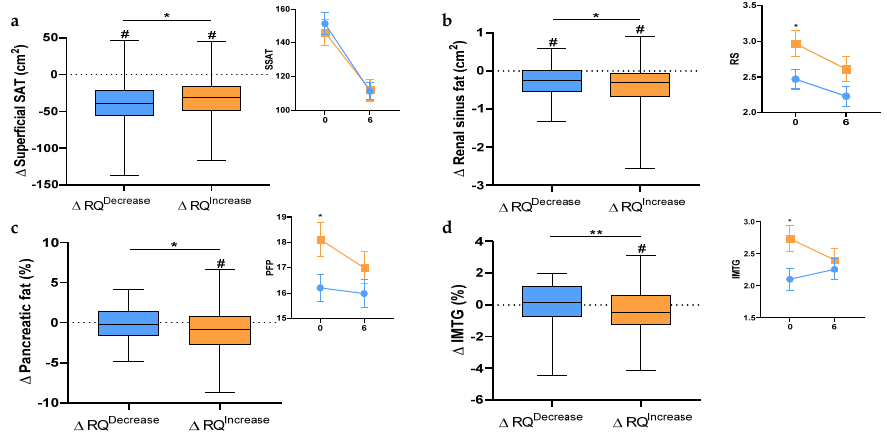
Figure A1. ( a – d ) Changes in body fat among people with a decrease (blue boxes) and increase (orange boxes) in RQ. Inserts: Body fat at baseline and after 6 months among people with decreased (blue) or increased RQ (orange). Un-paired samples t -test was used to compare between groups * p < 0.05; ** p < 0.01; paired samples t -test was used for comparisons between time-points # significant difference between baseline to 6 months. Abbreviations: IMTG intramuscular triglycerides; RQ-respiratory quotient; SAT—subcutaneous adipose tissue.